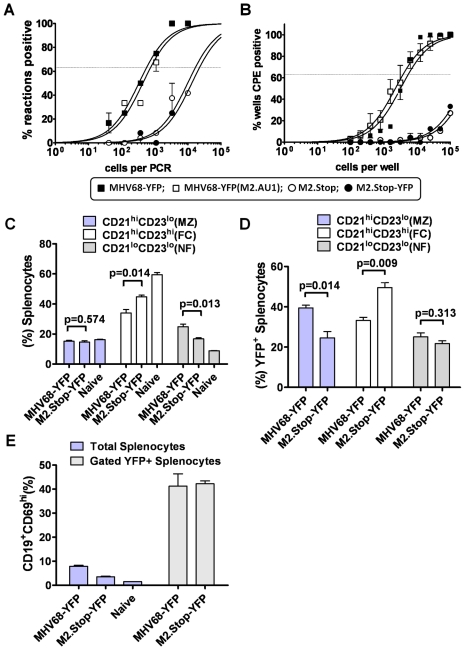
Distribution of M2 null virus in newly formed, marginal zone and follicular B cells in the spleen at the peak of latency is similar to wild type MHV68.(A and B) Insertion of a YFP expression cassette into the viral genome, or addition of an AU1 epitope tag on the C-terminus of M2, did not alter the phenotype of the M2 null virus. Latency and reactivation phenotypes of several YFP expressing MHV68 recombinant viruses were assessed using standard limiting dilution analyses to compare the eYFP expressing M2.Stop recombinant virus to the well characterized M2.Stop mutant, as well as different wt YFP expressing viruses - one of which contains an AU1 epitope tag on the C-terminus of M2. All data were pooled from two independent virus isolate, five mice infected with 100 pfu of the indicated virus via intranasal inoculation. (A) Limiting dilution PCR analyses of the frequency of splenocytes harboring viral genome following infection with the indicated recombinant viruses. (B) Limiting dilution analyses of MHV68 reactivation following explant of splenocytes harvested at day 16 post-infection. (C) Similar levels of marginal zone (MZ), follicular (FC) and newly formed (NF) B cells in spleens infected with wt MHV68-YFP or M2 null viruses (M2.stop-YFP). (D) Percentage of MZ, FC and NF B cells in virus infected (YFP+ cells) splenocytes with wt MHV68-YFP or M2 null viruses. (E) Percentage of activated B cells present in wt MHV68-YFP or M2 null virus infected spleen cells at day 16 post-infection. The p values indicated in the figure were determined by two-tailed, unpaired t test with a 95% confidence level.